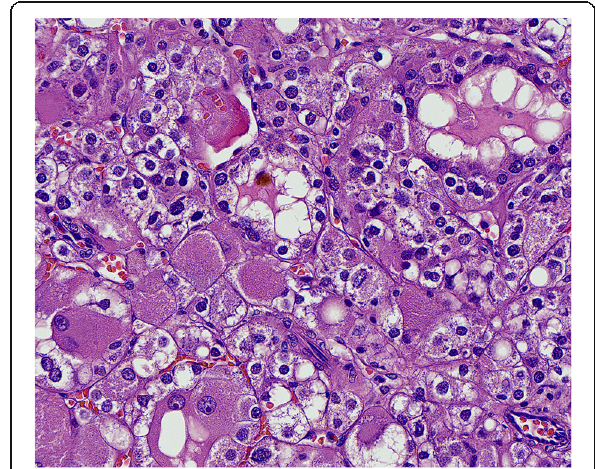
Fig. 4 Eosinophilic solid and cystic renal cell carcinoma. Solid area of tumor with typical tumor cells showing a moderate degree of nuclear pleomorphism and scattered prominent nucleoli. In occasional larger cells cytoplasmic vacuolation is